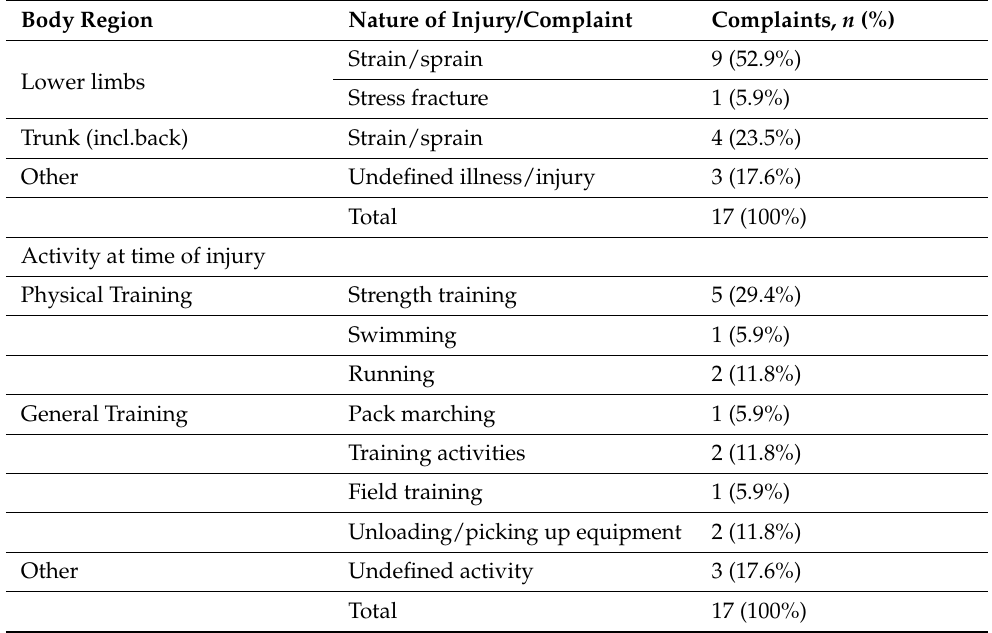
Table 2. The numbers and percentages of musculoskeletal and health complaints reported by the participants during BMT.